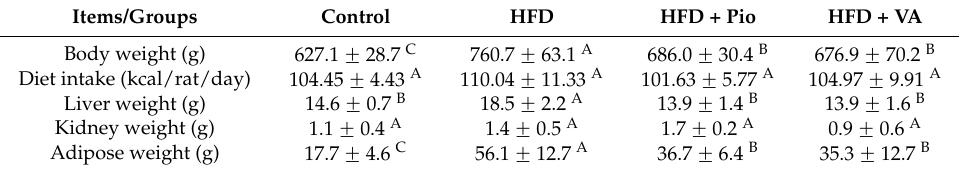
Table 2. The body weight, selected tissue weight, and energy intake in rats fed a high-fat diet for 16 weeks and orally administered with vanillic acid during the last 4 weeks.